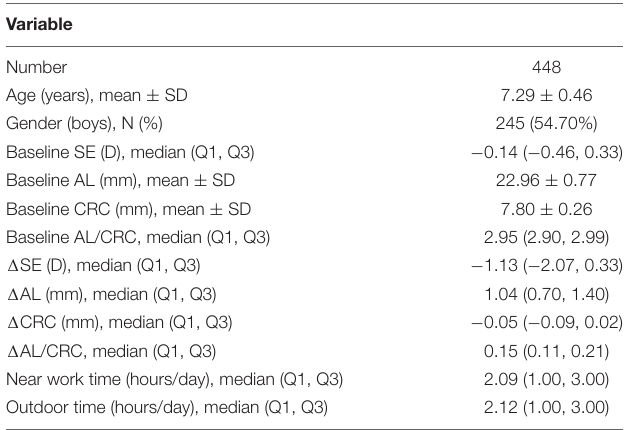
TABLE 2 | Characteristics of the